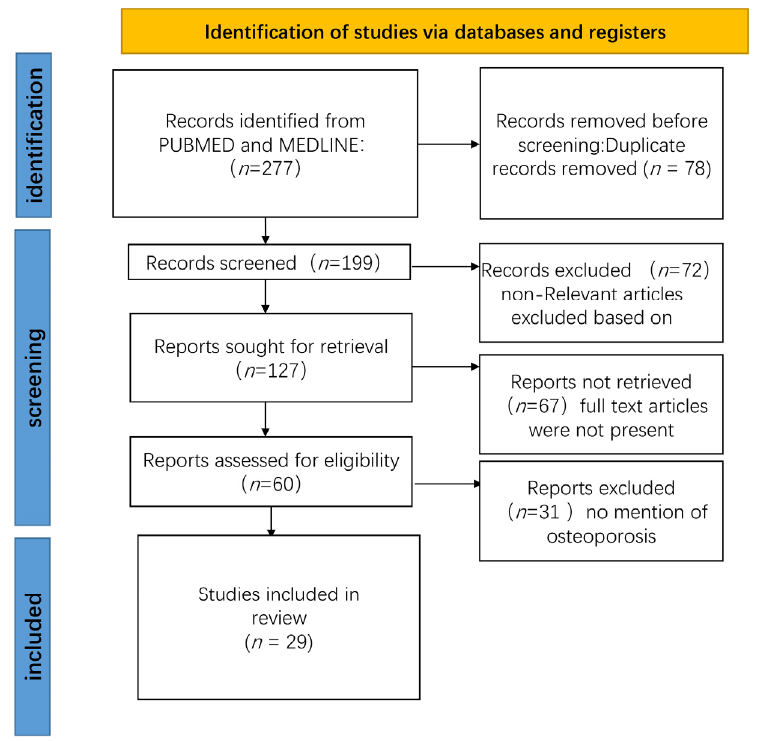
Figure 1. PRISMA flowchart showing the process of study selection.